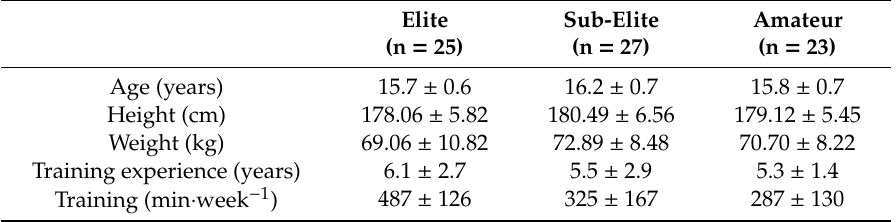
Table 1. Physical characteristics for elite, sub-elite, and amateur soccer players (Mean ± SD).